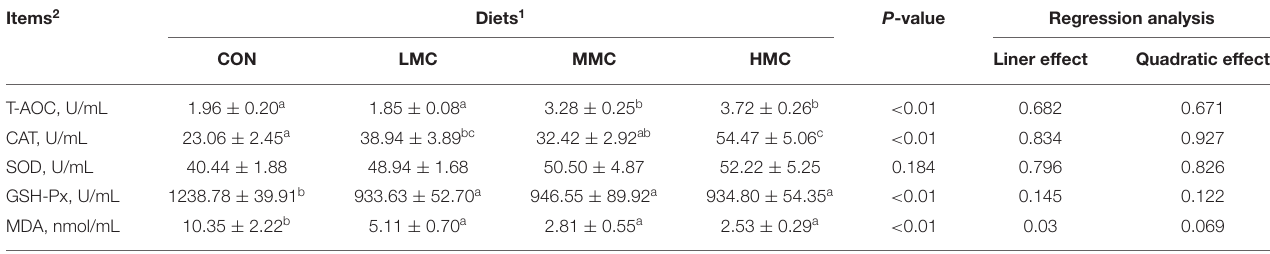
TABLE 5 | Effects of dietary Moutan cortex radicis on serum antioxidant indexes in growing